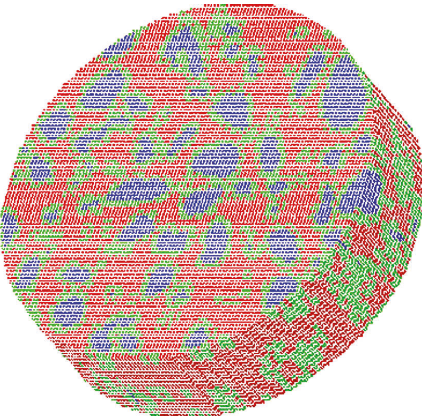
Figure 6: The specimen FEM elements.